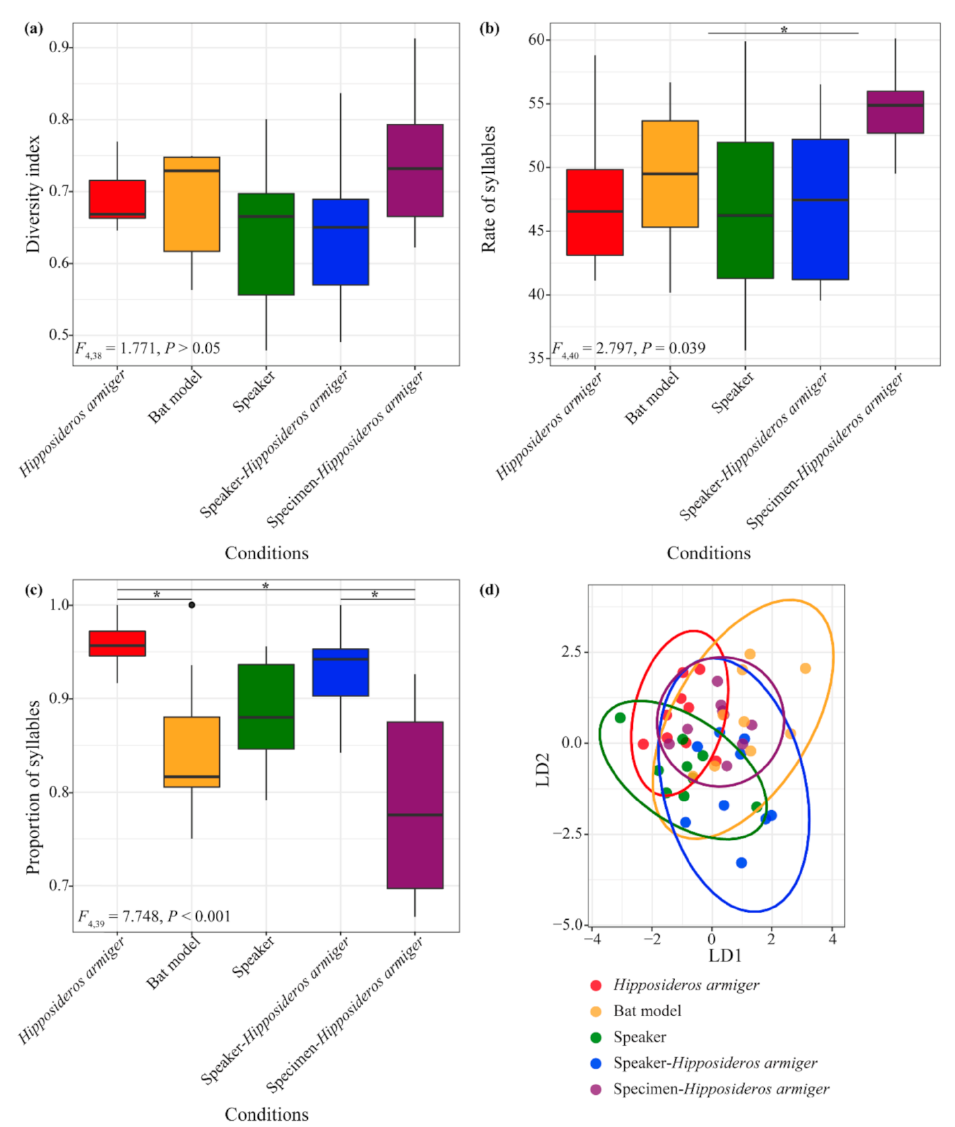
Figure 4. Di ff erences in territorial calls of Hipposideros armiger in response to invasion by non-living objects. ( a ) Diversity index of territorial calls; ( b ) syllable rate of territorial calls; ( c ) proportion of territorial calls that were sUFM syllables; ( d ) ellipses showing the 95% confidence intervals that were obtained from a discriminant function analysis of two principal component factor scores measured from sUFM territorial calls. Colors show grouping according to object identity ( n = 5). * p < 0.05. LD1, linear discriminant function 1; LD2, linear discriminant function